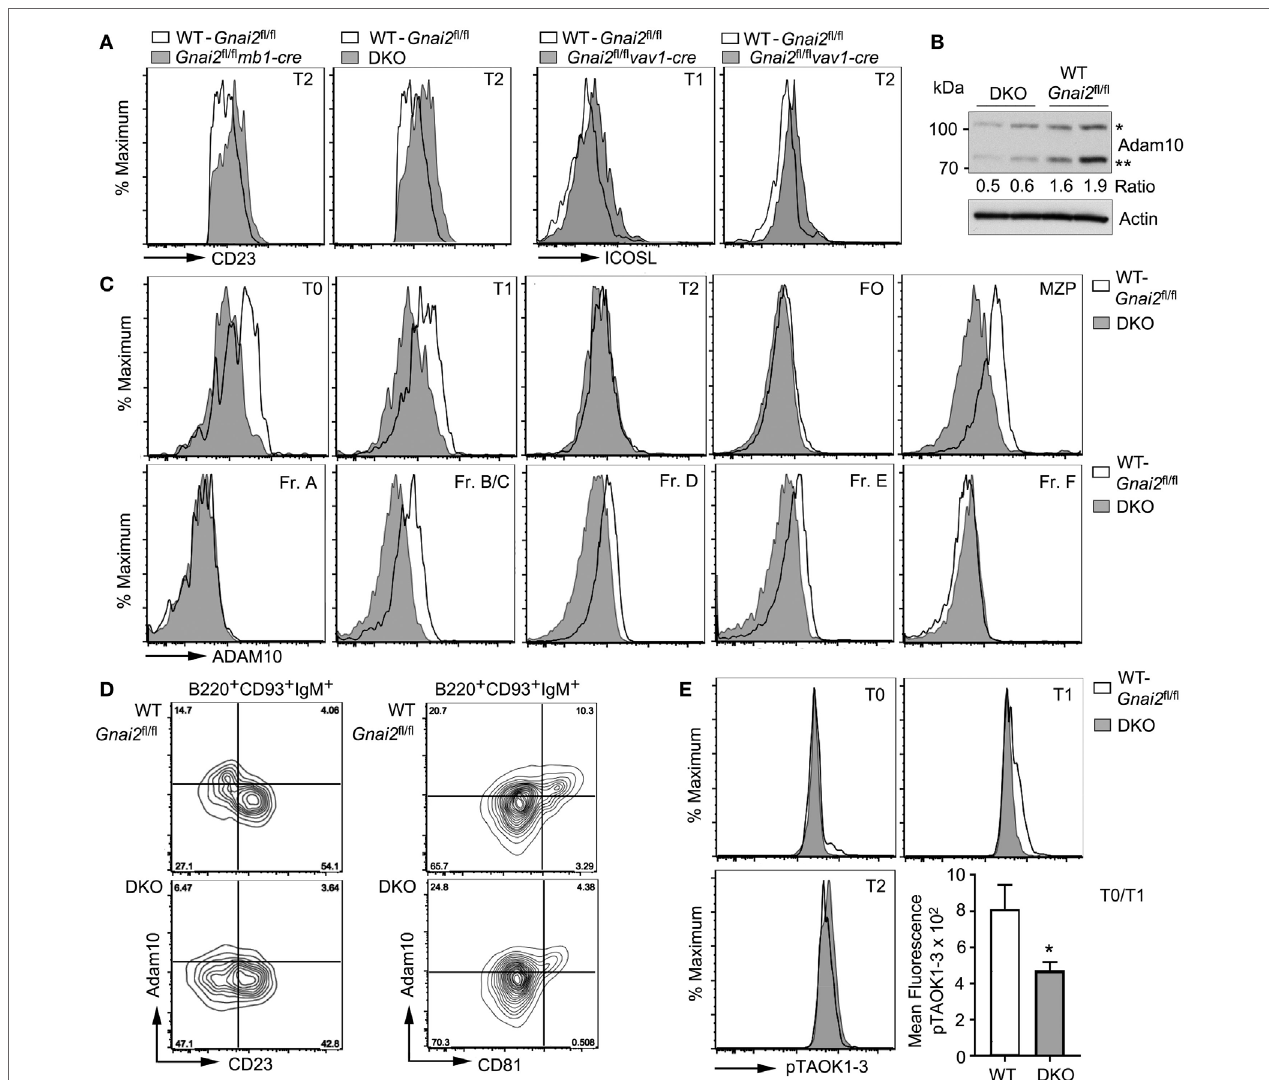
FigUre 4 | Reduced ADAM10 processing and expression in G α i -deficient transitional B cells. (a) CD23 or ICOSL expression on G α i -deficient B cells. Representative flow cytometry patterns of CD23 expression on transitional B cell type 2 (T2) cells from WT ( Gnai2 fl/fl ) and either Gnai2 fl/fl mb1-cre or double knockout (DKO) mice and ICOSL on transitional B cell type 1 (T1) and T2 cells from Gnai2 fl/fl vav1-cre mice. (B) Immunoblot to detect ADAM10 expression in lysates from two WT ( Gnai2 fl/fl ) and two DKO splenic B cells. Experiment repeated twice with equivalent results. The ratio between the unprocessed (*) and mature (**) ADAM10 is show. Actin immunoblot shown to verify equal loading. (c) Flow cytometry showing expression of ADAM10 in bone marrow and in splenic B cell fractions. Experiment was repeated a minimum of three times with a similar result. (D) ADAM10 expression on B220 + CD93 + IgM + spleen cells as a function of CD23 or CD81 expression using cells from WT ( Gnai2 fl/fl ) or DKO mice. Flow cytometry showing a plot of ADAM10 versus CD23 (left) or CD81 (right). The % of positive cells in each quadrant is indicated. (e) pTAOK expression in WT ( Gnai2 fl/fl ) and DKO splenic B cells. Intracellular flow cytometry assessing phosphorylation of TAOK proteins in splenic B cells from WT and DKO mice. Quantification of pTAOK proteins in transitional B cell type 0 (T0) and T1 B cells as measured by flow cytometry from four WT and four DKO mice. Data are mean ± SEM (* p <